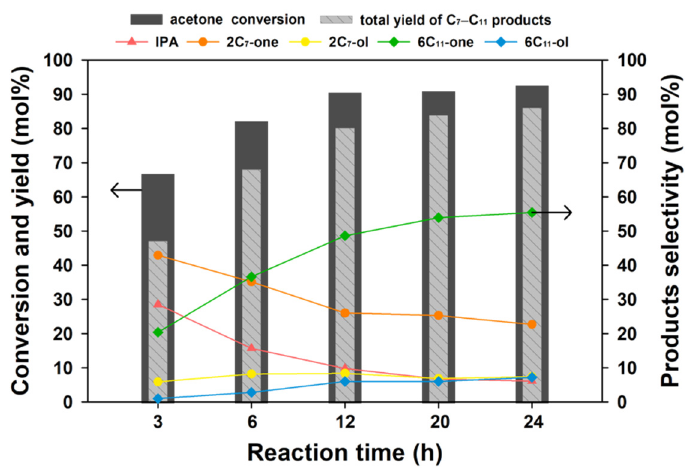
Figure 8. Effect of reaction time on the catalytic performance of 5 wt % Cu/Pr 2 Zr 2 O 7 in the cross ‐ coupling of acetone with butanol. Reaction conditions: 20 g reactant with the butanol/acetone mole ratio of 2, catalyst 1 g, and 240 °C.